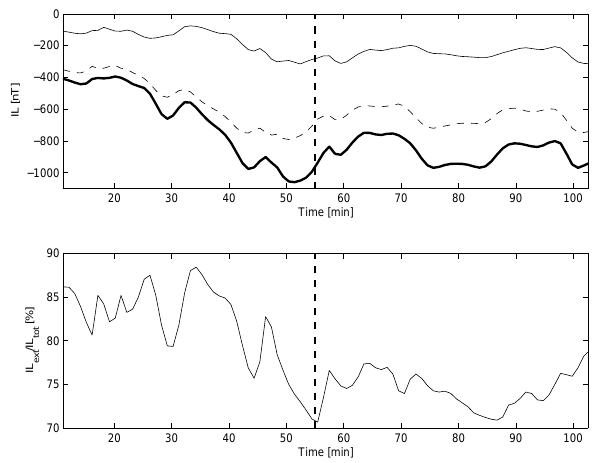
Fig. 6. Top panel: modeled external (dashed), internal (thin solid) and the total IL (thick solid) index. bottom panel: ratio between the external IL and the total IL . time is minutes from the beginning of the modeling period of 26 June 1998, 01:00 UT. The dashed line indicates the time 01:55